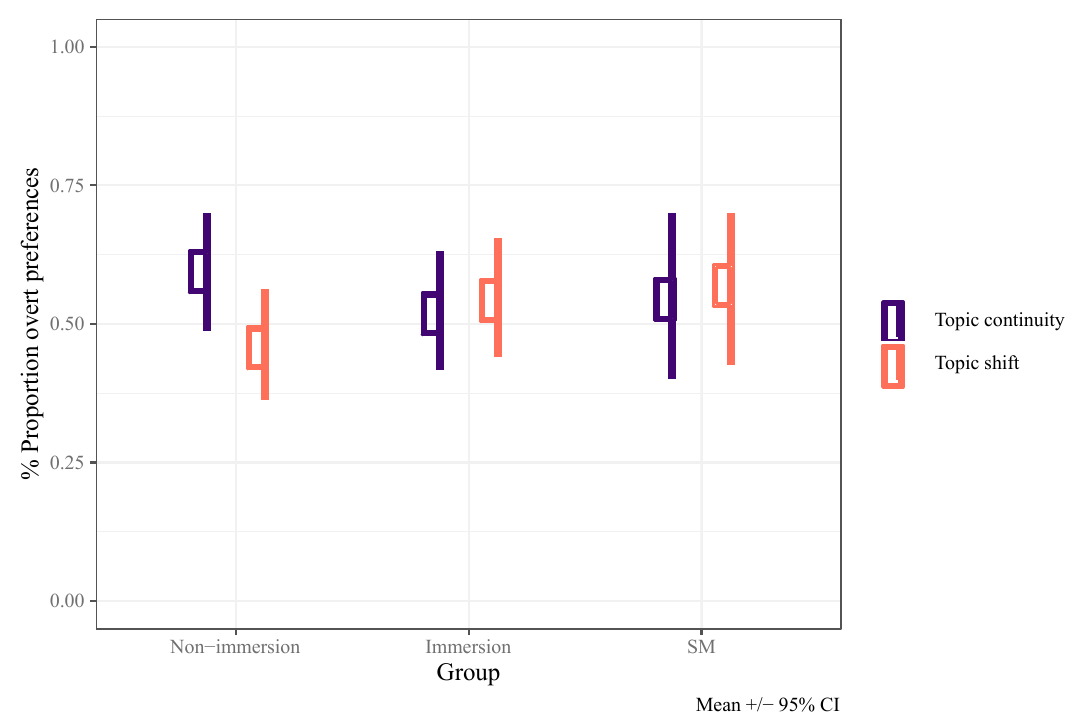
Figure 3. Proportion of overt pronoun responses in Spanish in topic shift and topic continuity conditions. Table 4. Coefficients in Spanish.